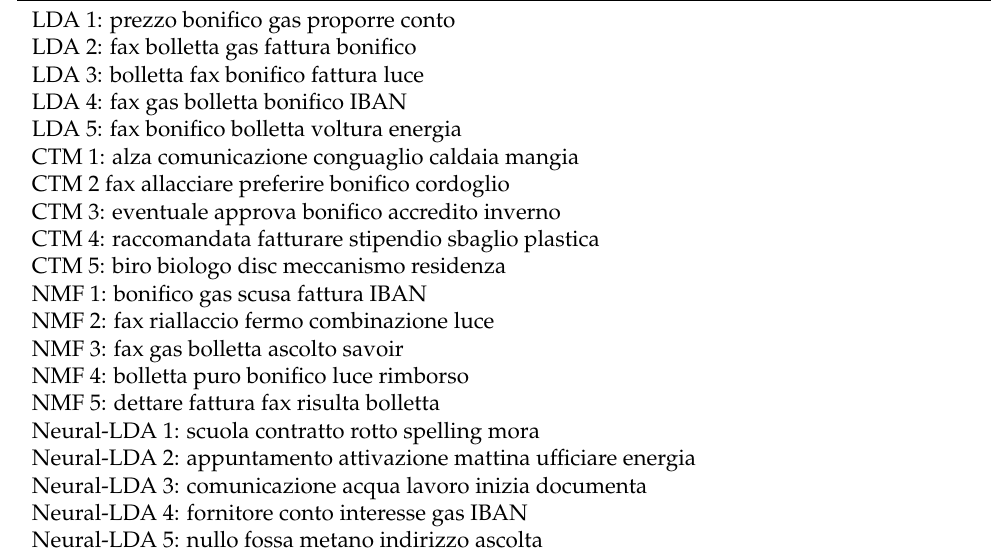
Table 2. Top ten words for five topics, using k = 20.